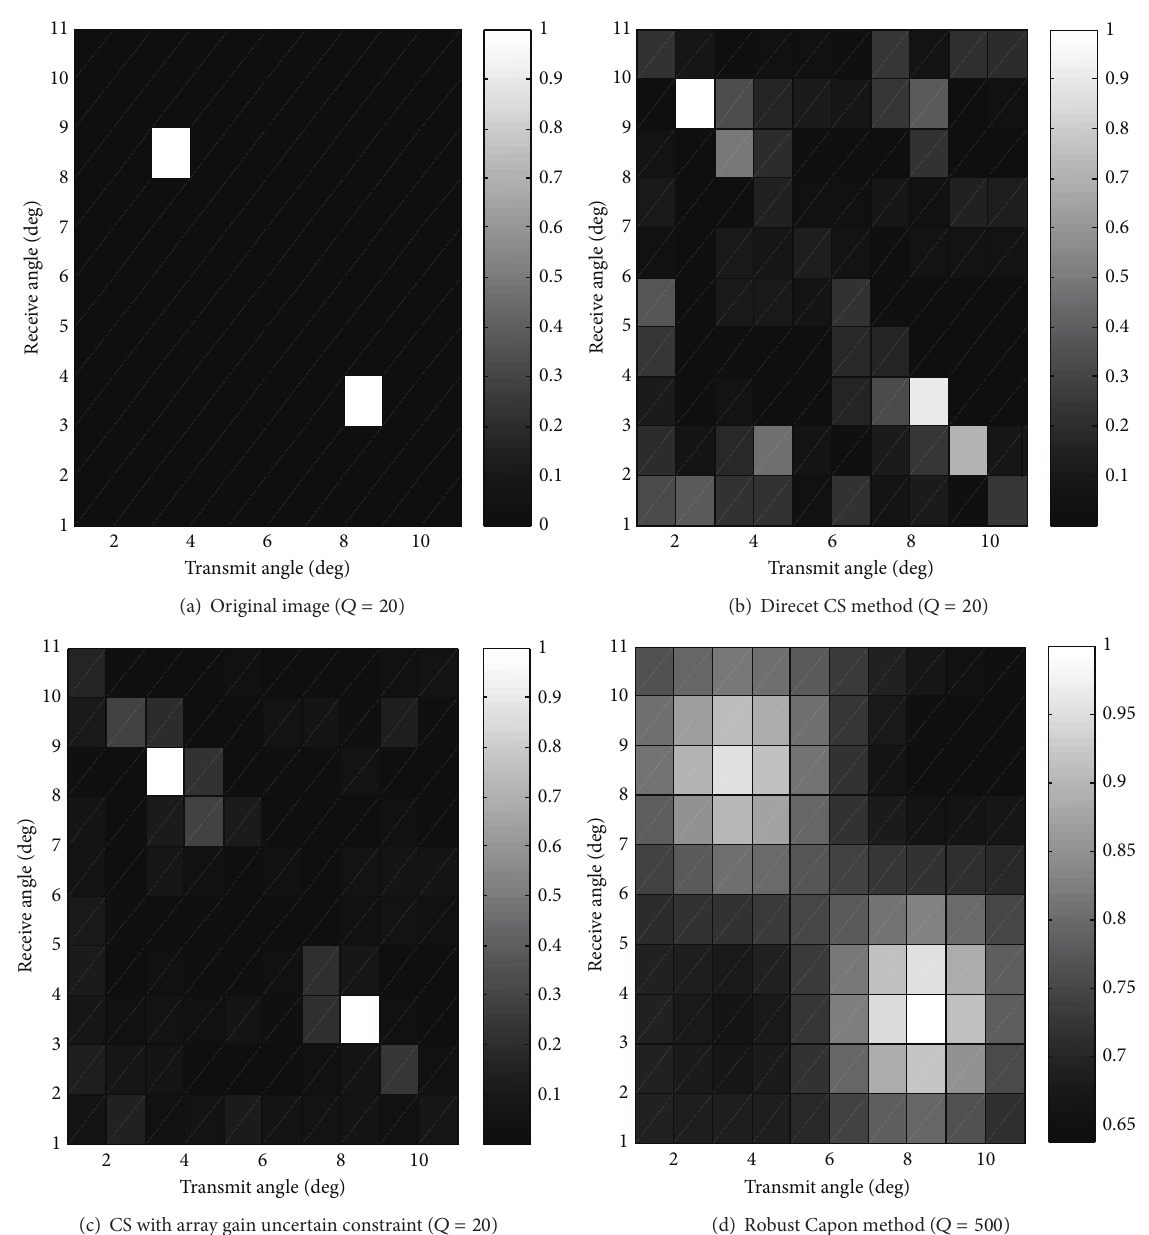
Figure 3: The performance of the proposed method with large array gain uncertain ( 𝑀 = 𝑁 = 20 , [𝜃 𝑡1 , 𝜃 𝑟1 ] = [8 ∘ ,3 ∘ ] , [𝜃 𝑡1 ,𝜃 𝑟1 ] = [3 ∘ , 8 ∘ ] , = 𝜎 = 0.8 𝑄 = 20 , SNR = 10dB, 𝜎 𝑡 𝑟